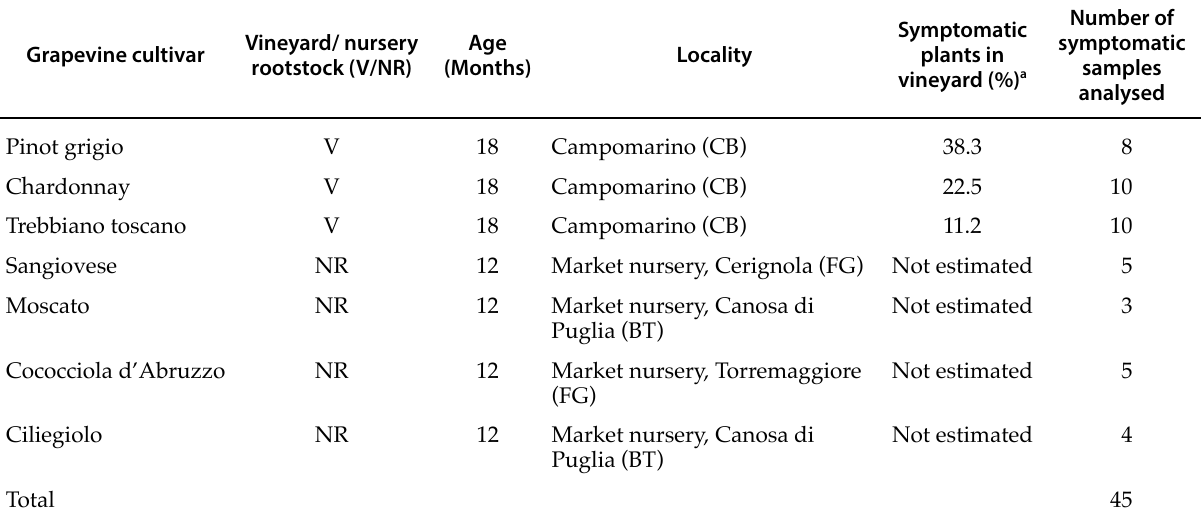
Table 1. Characteristics of young grapevine and nursery rootstock analysed. Grapevine